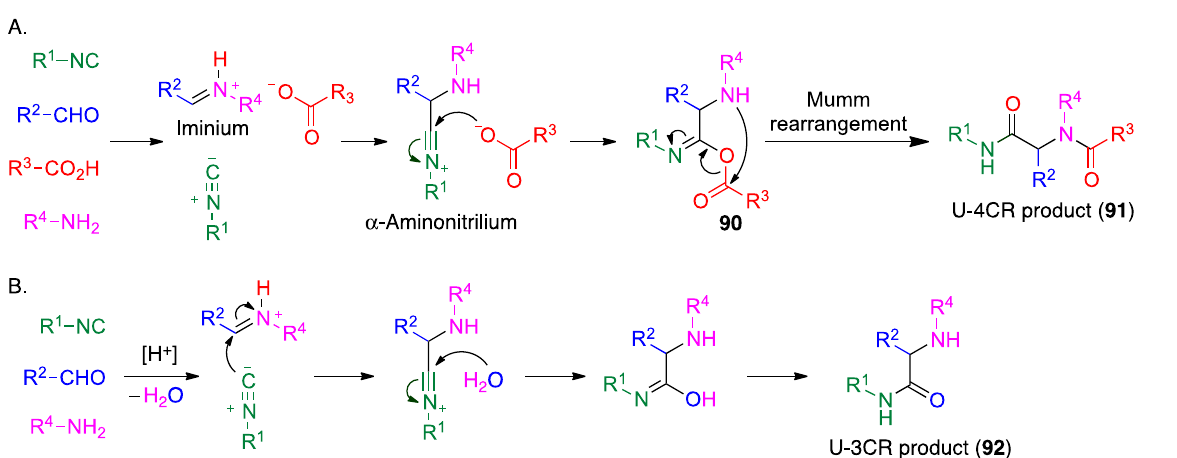
Scheme 41. The Ugi ‐ 4CR ( A ) and Ugi ‐ 3CR ( B ) reactions and their